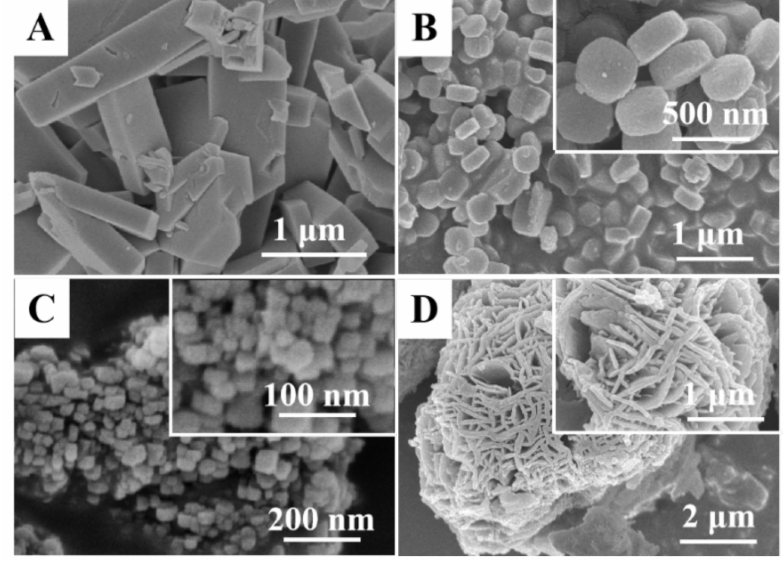
Figure 1. SEM images of: ( A ) Pt / CZ, ( B ) Pt / Z-400, ( C ) Pt / Z-40, and ( D ) Pt / NS-2